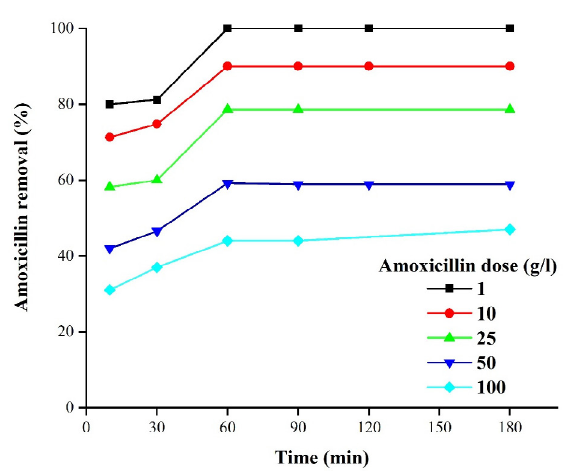
Fig. 4. Effect of amoxicillin concentration on removal